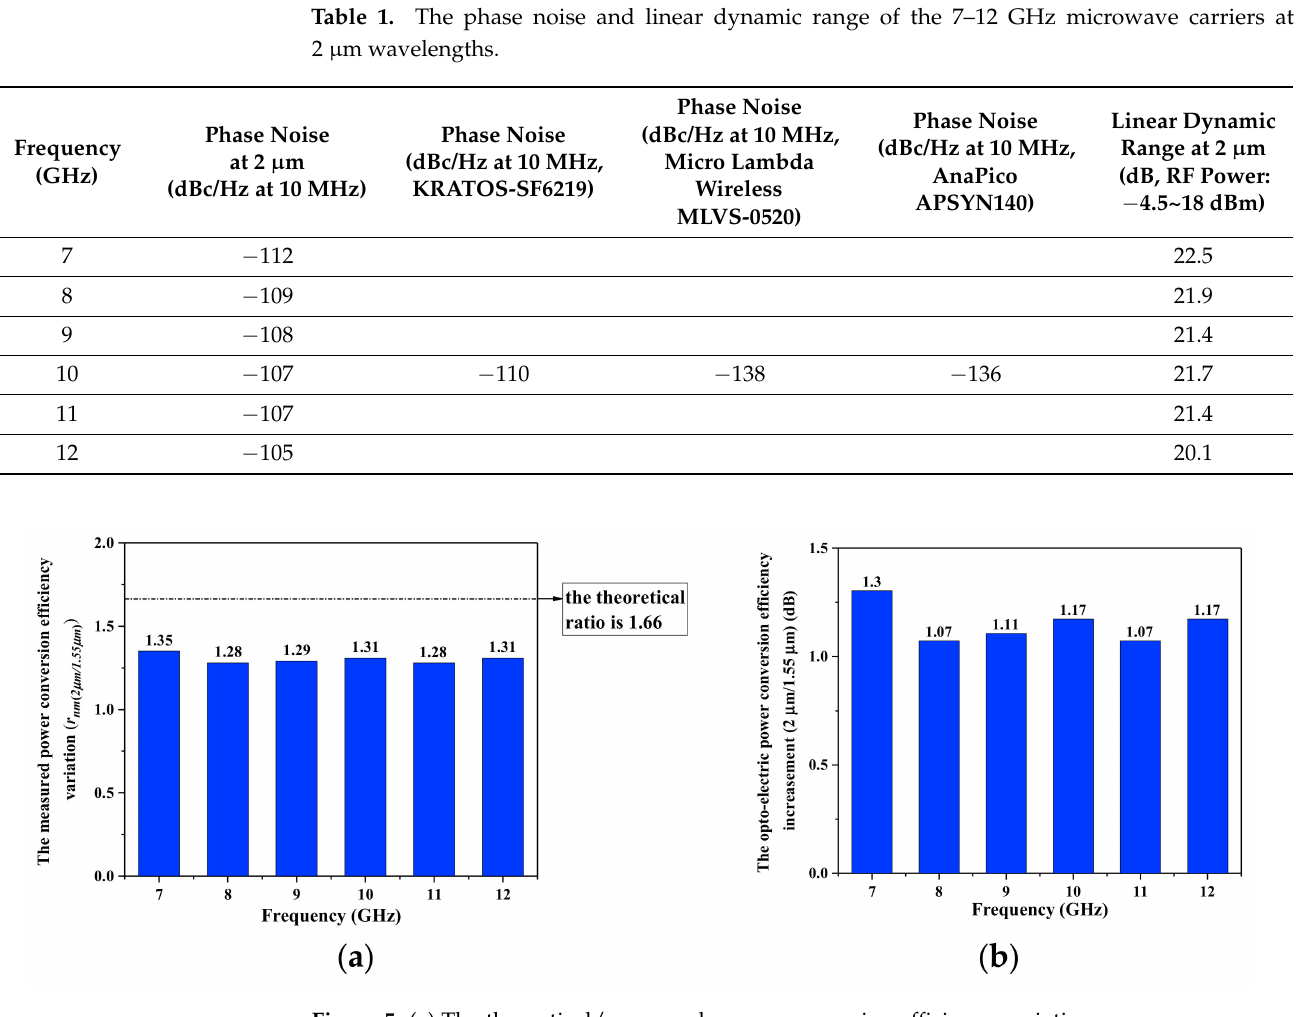
Figure 5. ( a ) The theoretical/measured power conversion efficiency variation r nm ( 2 µ m/1.55 µ m ) = 2 2 ) ; ( b ) the opto-electric power conversion efficiency increasement ( P ) / ( P E 2 µ m / η E 1.55 µ m / η 2 µ m 1.55 µ m (2 µ m/1.55 µ